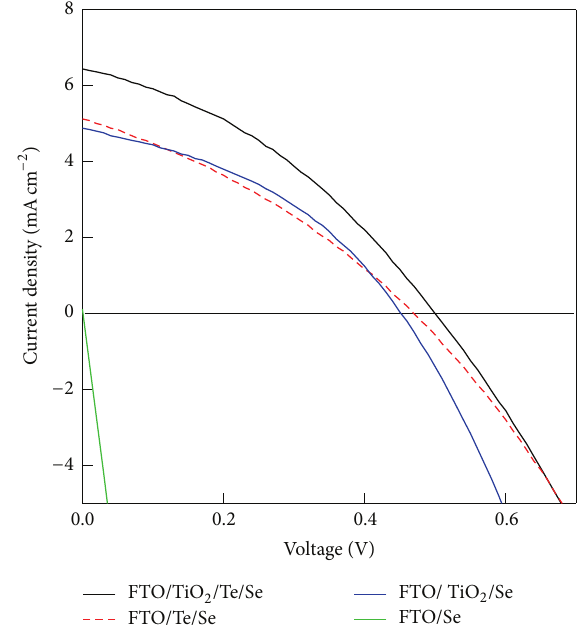
Figure 7: Photocurrent-voltage curves of electrochemically depos- ited selenium solar cells. Each cell size was 25 mm 2